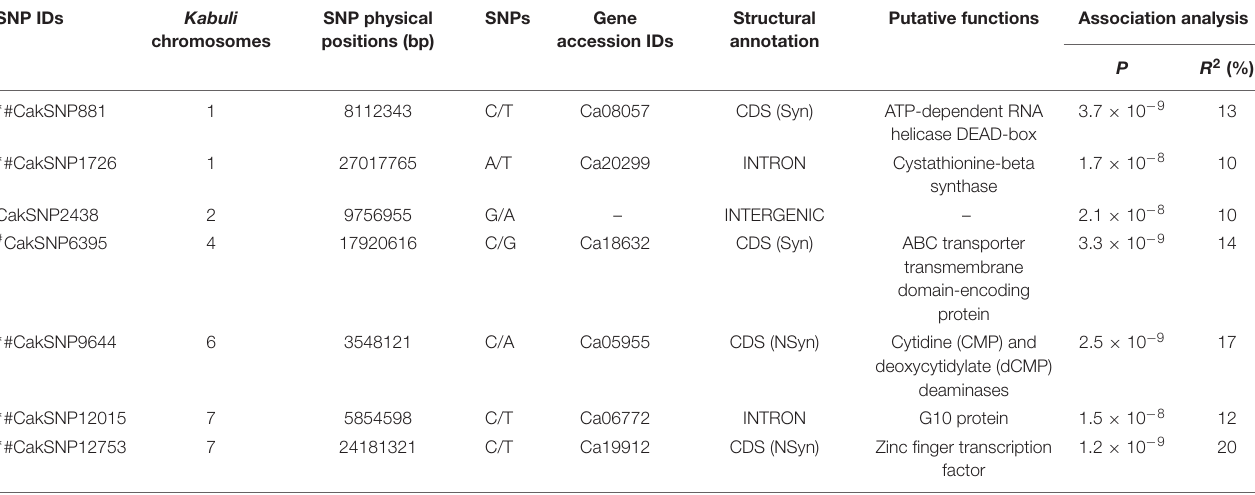
TABLE 2 | Seven SNPs-containing genes regulating seed protein content delineated by using an integrated genomic approach in chickpea. SNP IDs Kabuli SNP physical SNPs Gene Structural Putative functions Association analysis chromosomes positions (bp) accession IDs annotation P R 2